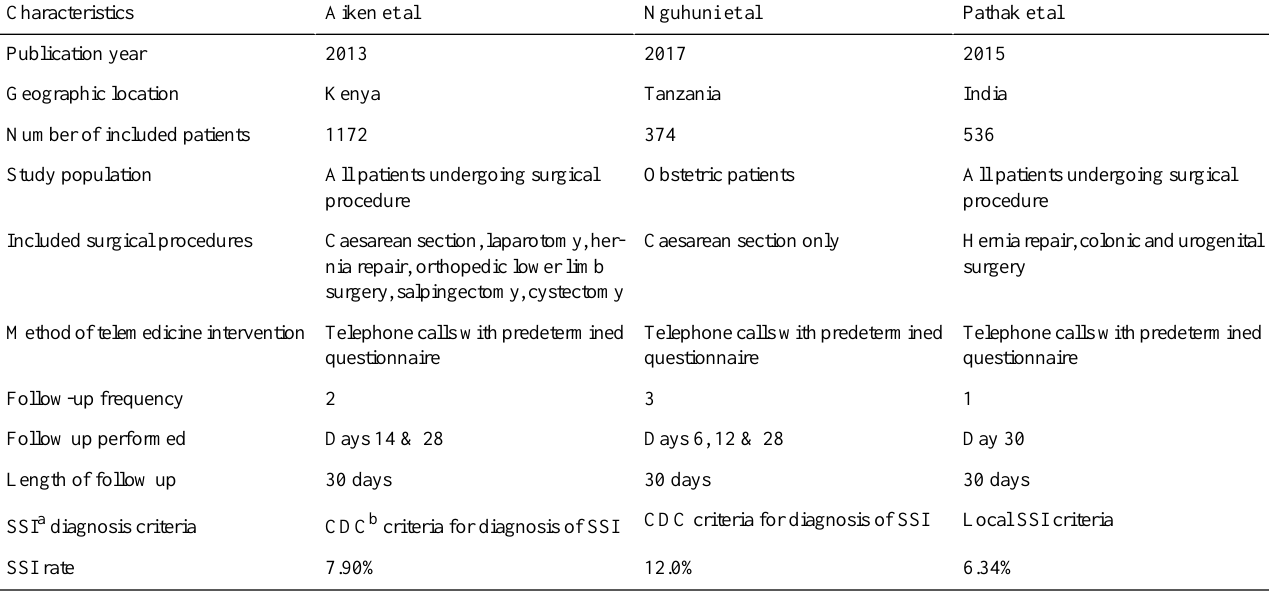
a SSI: surgical site infection b CDC: centers for disease control and